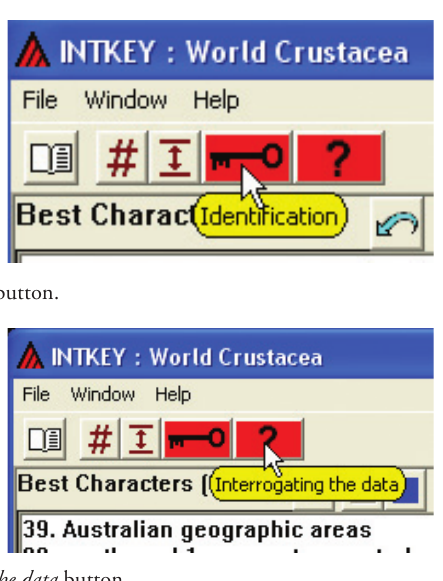
Figure 41. Interrogating the data